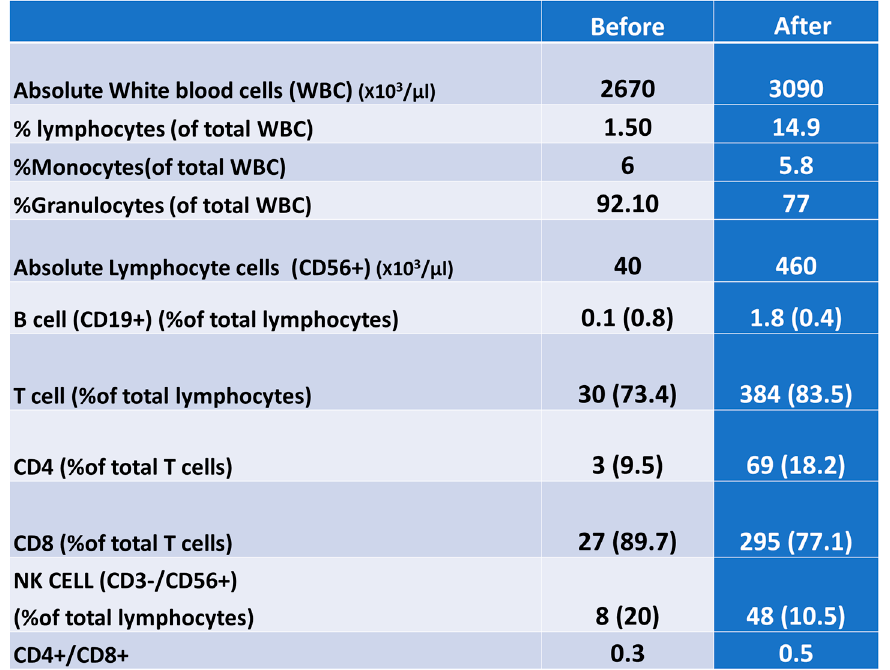
Figure 2. Analysis of leucocytes differential and lymphocyte subsets proportion by flow cytometry.